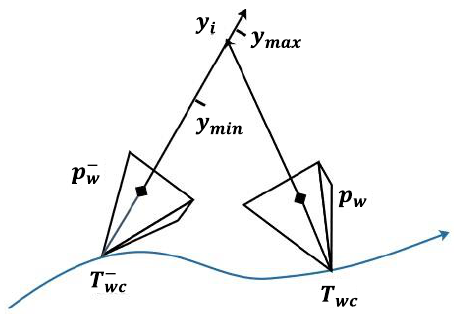
Figure 4. Depth filter measurement model. 3D space projection is performed between the current template position T wc and the previous template T − wc corresponding to the 2D coordinates. As the number of corresponding template matching increases, the distribution of depth gradually converges.